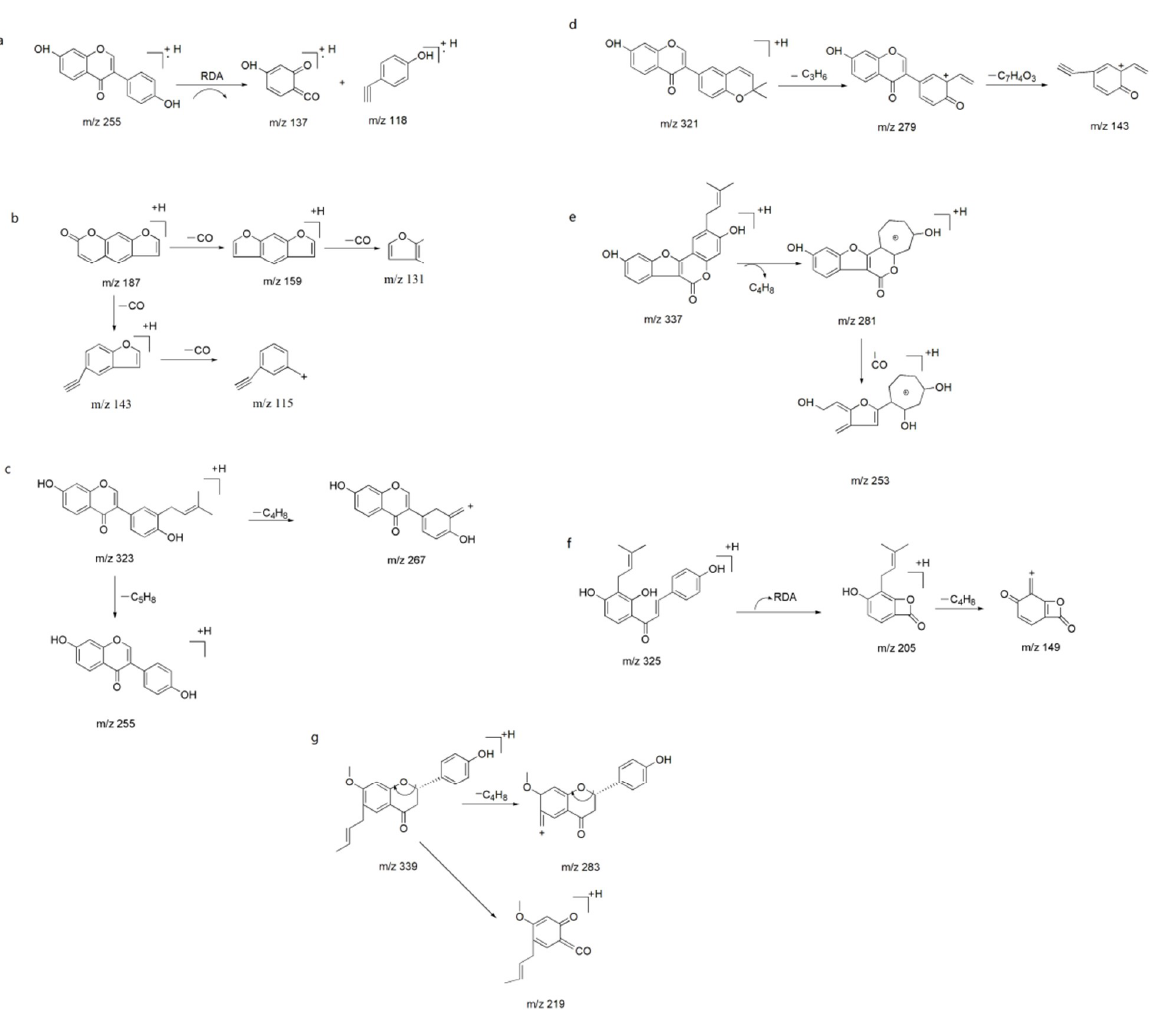
Figure 5. The proposed fragmentation pathways of ( a ) daidzein, ( b ) psoralen, ( c ) neobavaisoflavone, ( d ) corylin, ( e ) psoralidin, ( f ) isobavachalcone, and ( g ) bavachinin A.